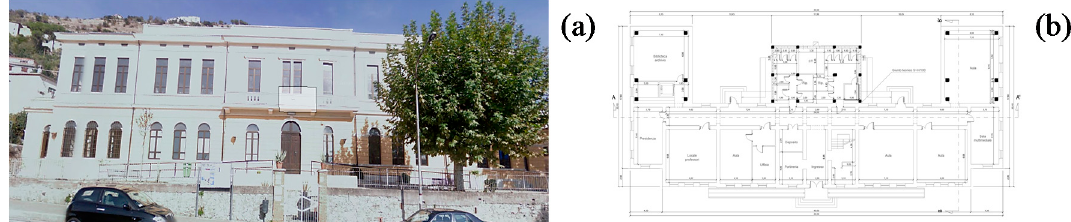
Figure 13. The cluster 1 reference school building (Building 1): ( a ) actual view; ( b ) building ground floor map.